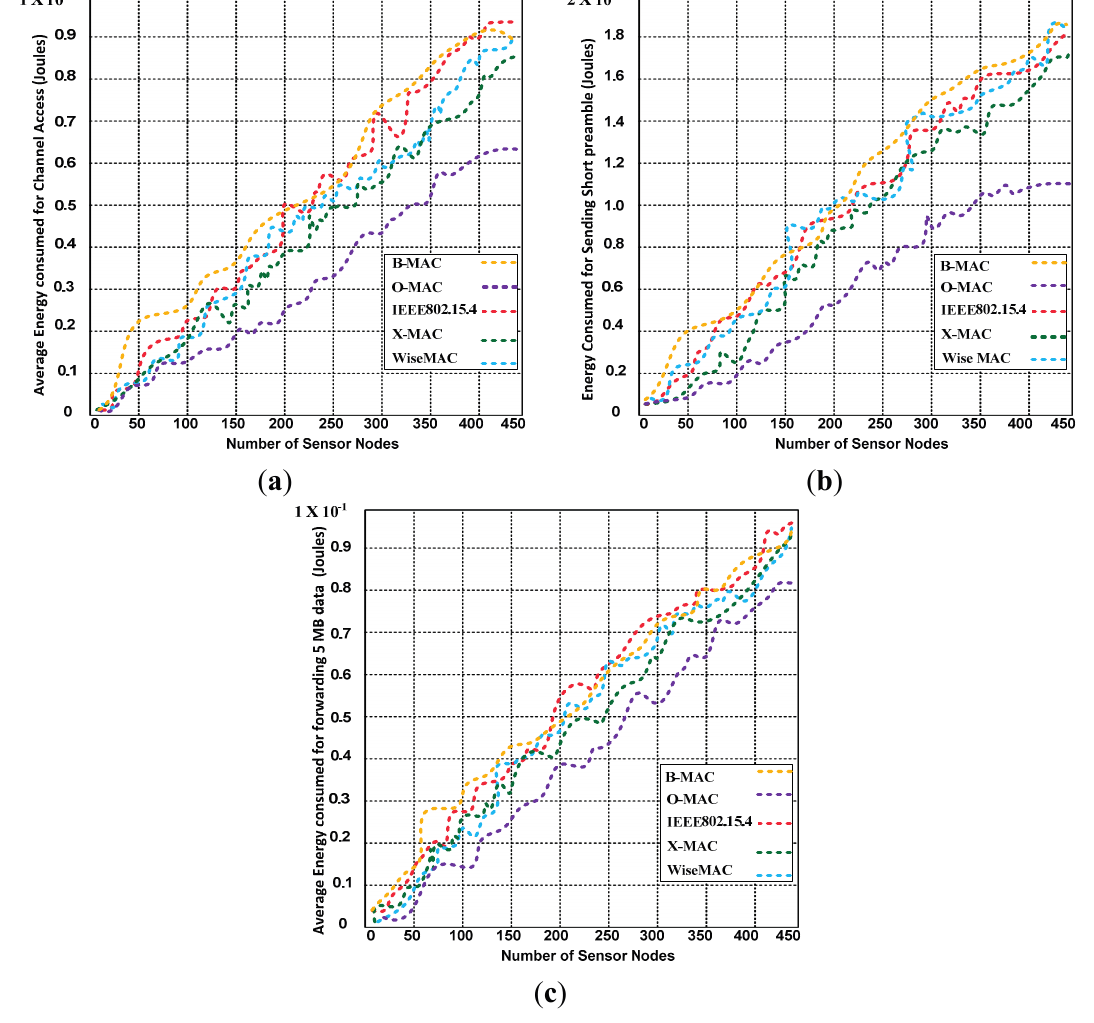
Figure 5. ( a ) Average energy consumed to access the channel; ( b ) Average energy consumed to forward the short preamble and ( c ) Average energy consumed to forward 5 MB of data